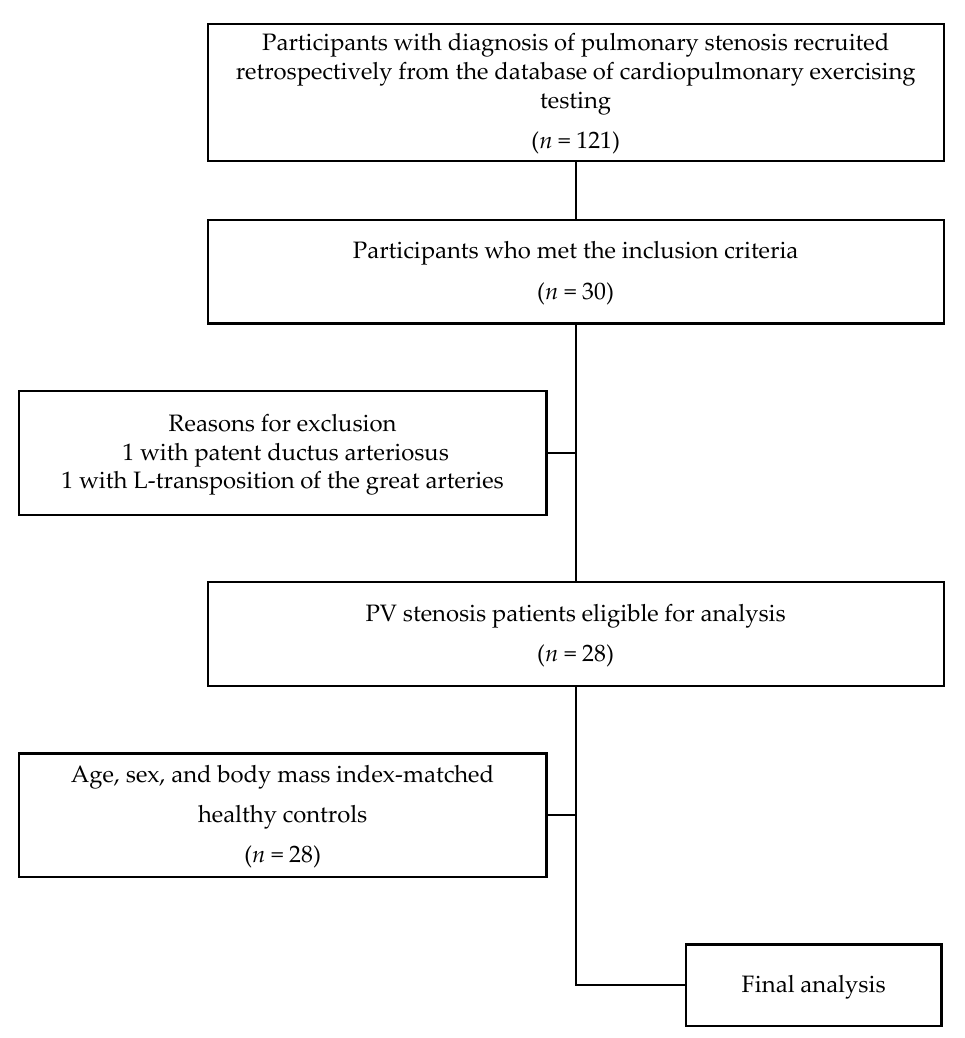
Figure 1. Patient selection process. Table 1. Demographic characteristics of patients with pulmonary valve stenosis.